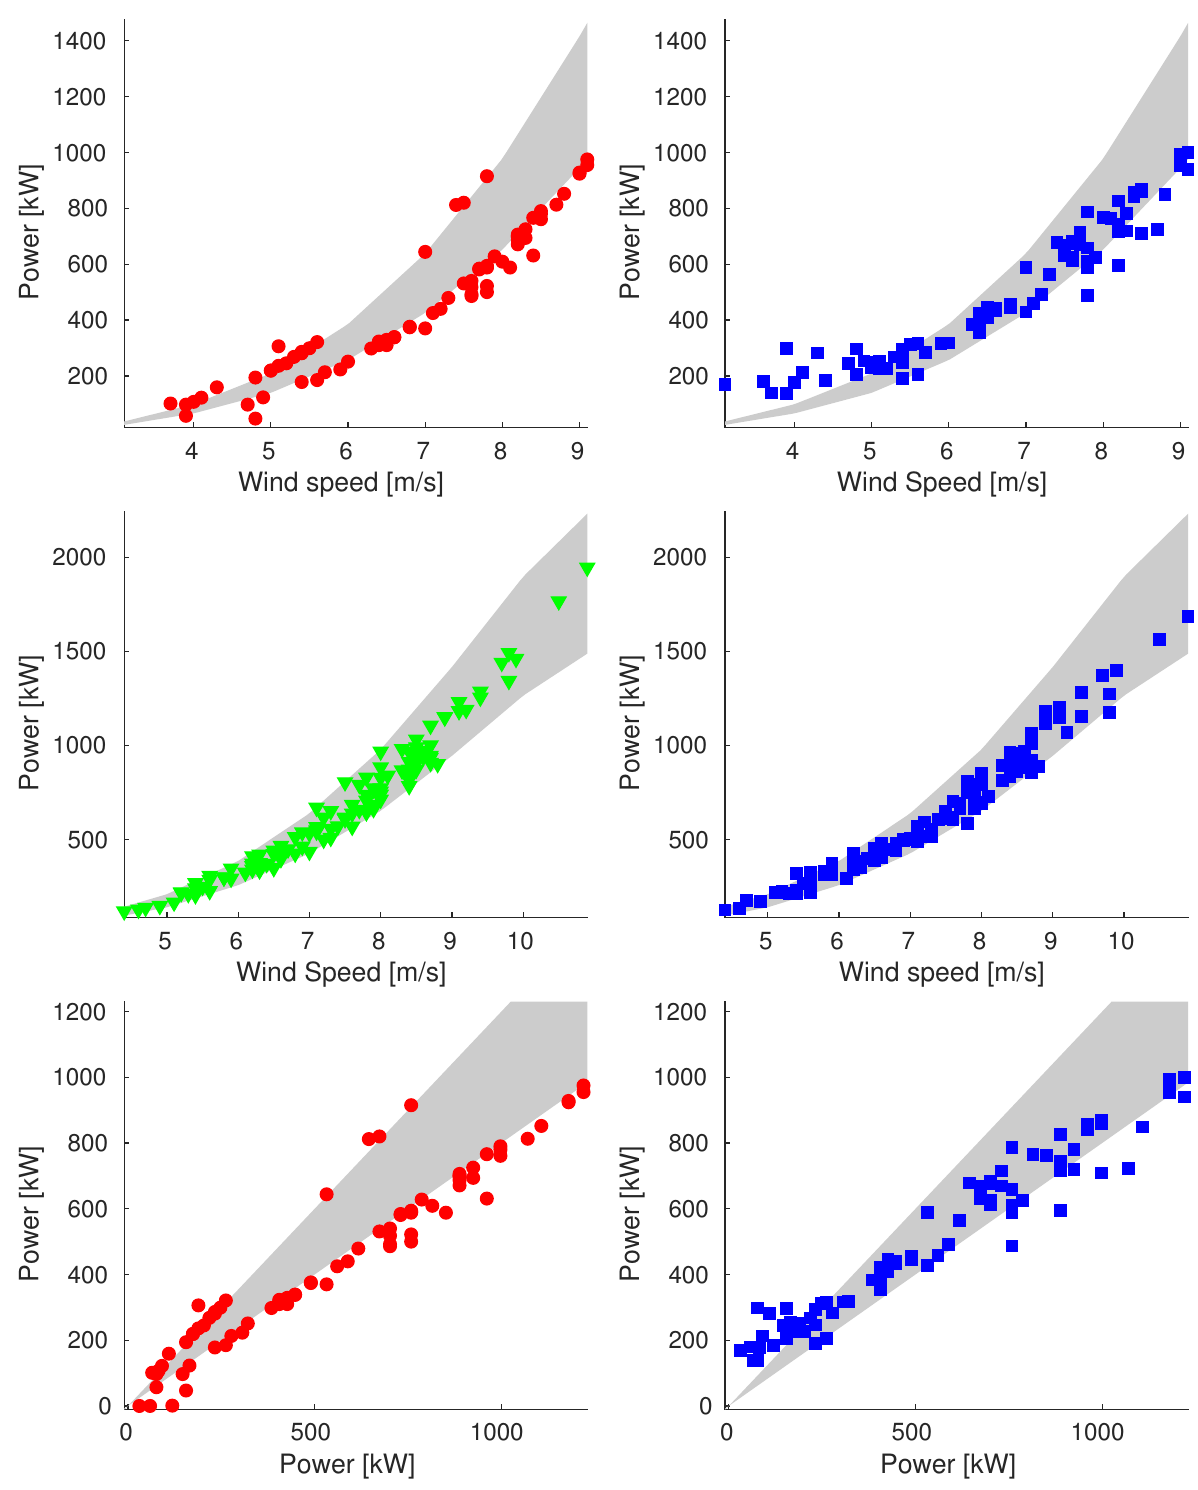
Figure 6. Plot of reconstructions for data points of 15 September 15 ( Sample_100 ). We compare original data (on the left ) and reconstructed values (on the right ). We show plots of power vs. wind speed of rejected and validation data ( up and middle , respectively) and plot of power vs. ideal power of rejected data ( bottom